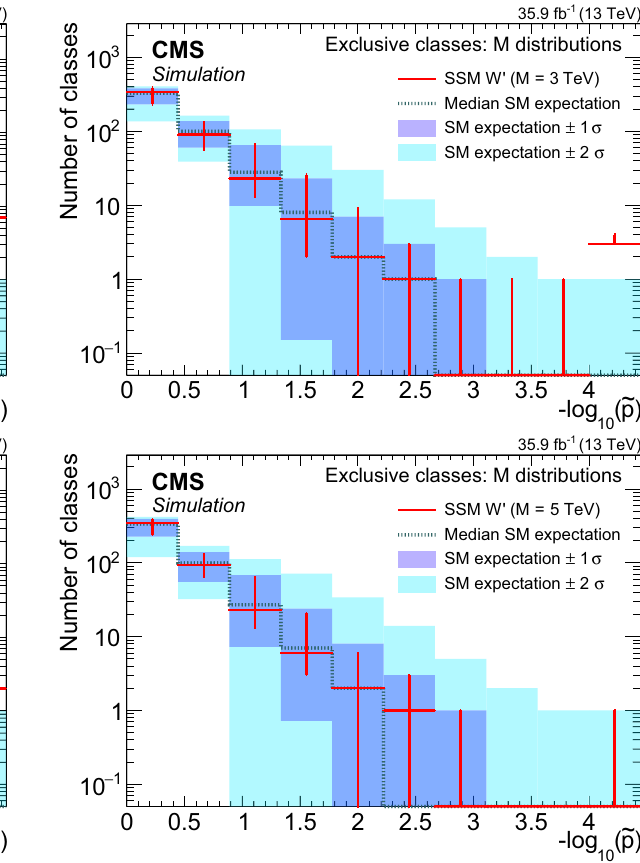
Fig. 5 Distributionof ˜ p valuesfortheRoIscaninexclusiveclassesfor theinvariantmass(transversemassforclasseswith p miss values for the mass of the SSM W (cid:11) boson of 2 (upper left), 3 (upper